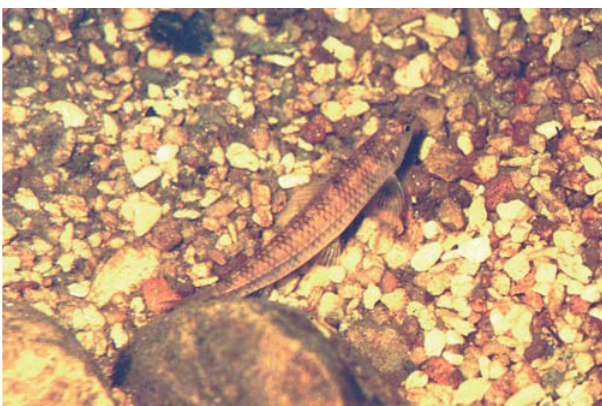
Fig. 5. Characidium zebra specimen using its expanded and horizontally orientated paired fins to hold its position against the current in the riffles substrate, during daytime (photo: Ricardo M.C. Castro).